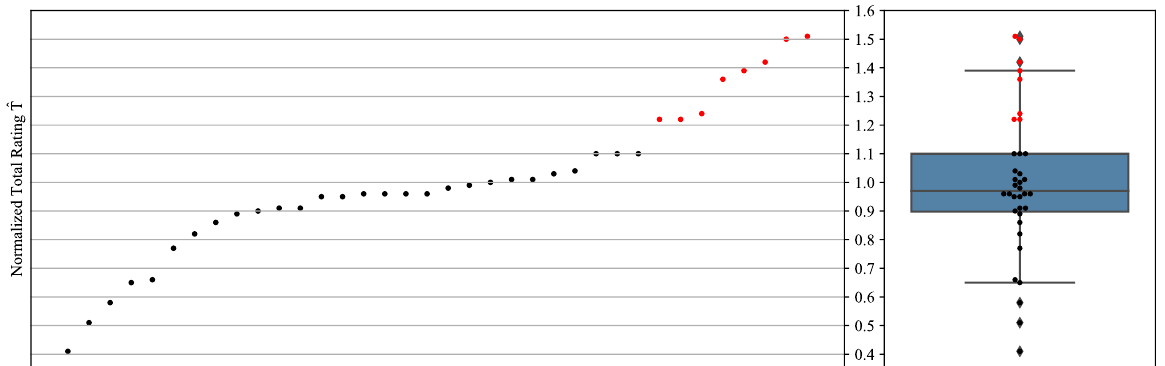
Table 7. The selected studies, their subgroups, and normalized total ratings.